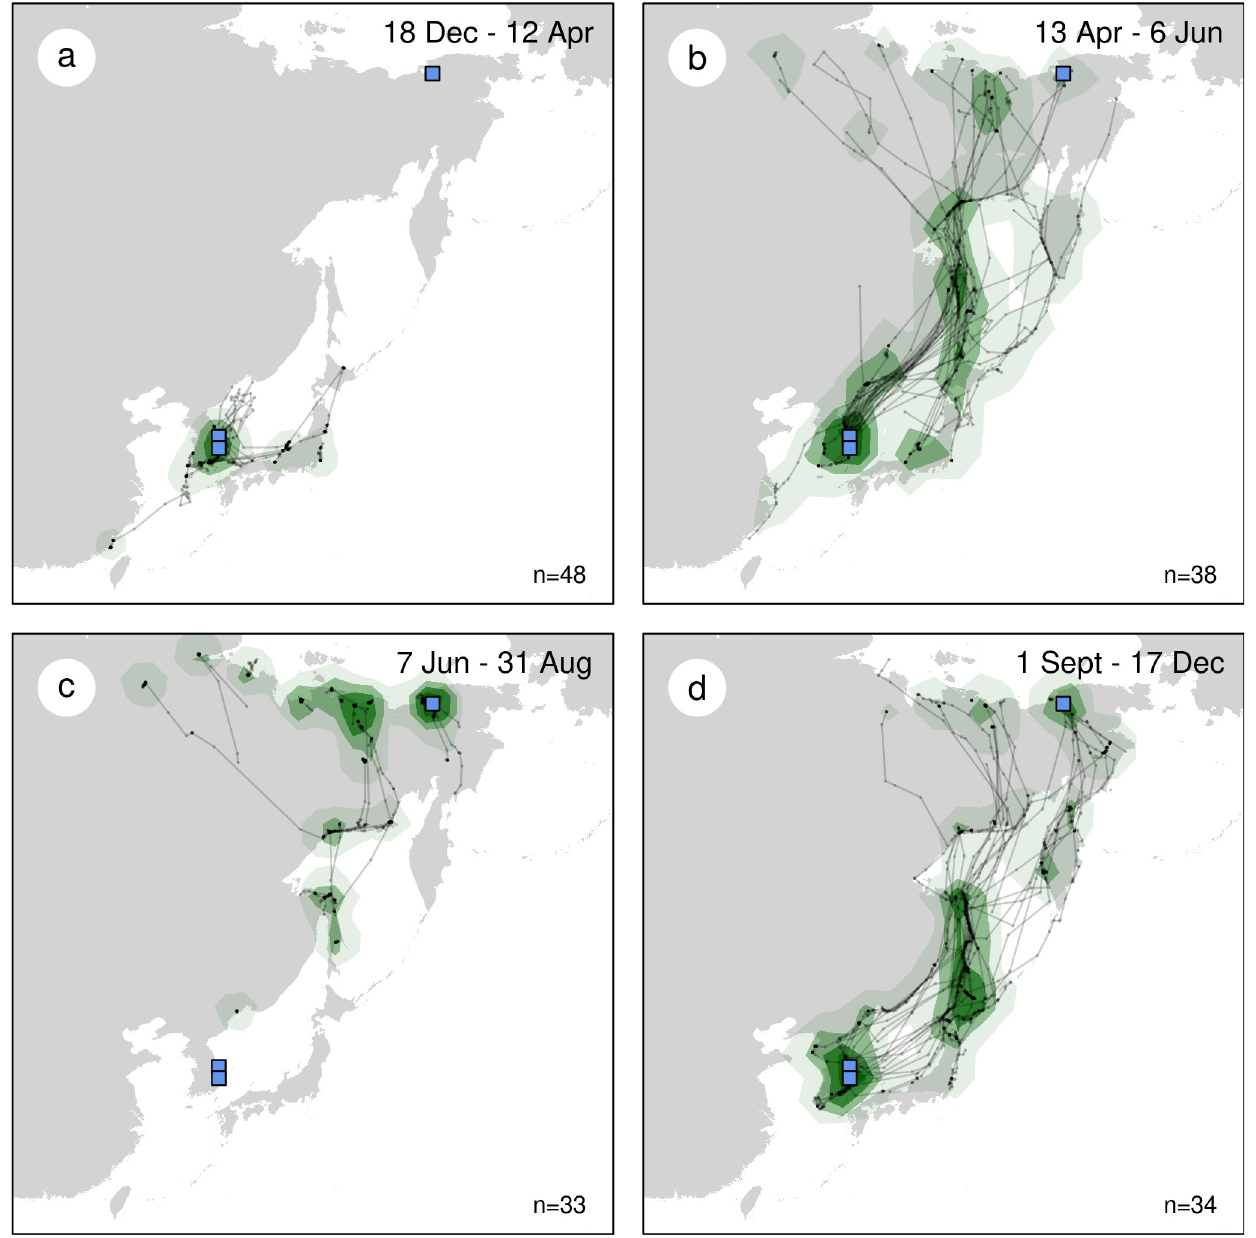
Fig 1. Individual tracks (black lines) and seasonal Kernel Utilisation Distribution (KUD; smoothing factor: 100 km) maps based on the movements of 28 Vega gulls. Blue squares show trapping sites. The four panels present the four seasons of the Vega gull annual cycle (a winter, b spring, c summer, d autumn), with spring and autumn defined as the periods when birds migrate (see S1 Fig (DC = 2) and [35]). The map used as the background was downloaded from http://thematicmapping.org/downloads/world_borders.php and has a Creative Commons Attribution license CC BY-SA 3.0. immatures and non-breeding birds spent their summer (S3 Fig), equals to 3,000–3,500 km (depending on the exact departure point from the Korean Peninsula) for a bird following the above-described flyway on a straight flight. Flying along Japan adds ca. 500 km to this flyway, and up to 750 km for birds using the easternmost route over the Kuril Islands and the Kam- chatka Peninsula. Reaching the breeding grounds above the Arctic circle from the southern